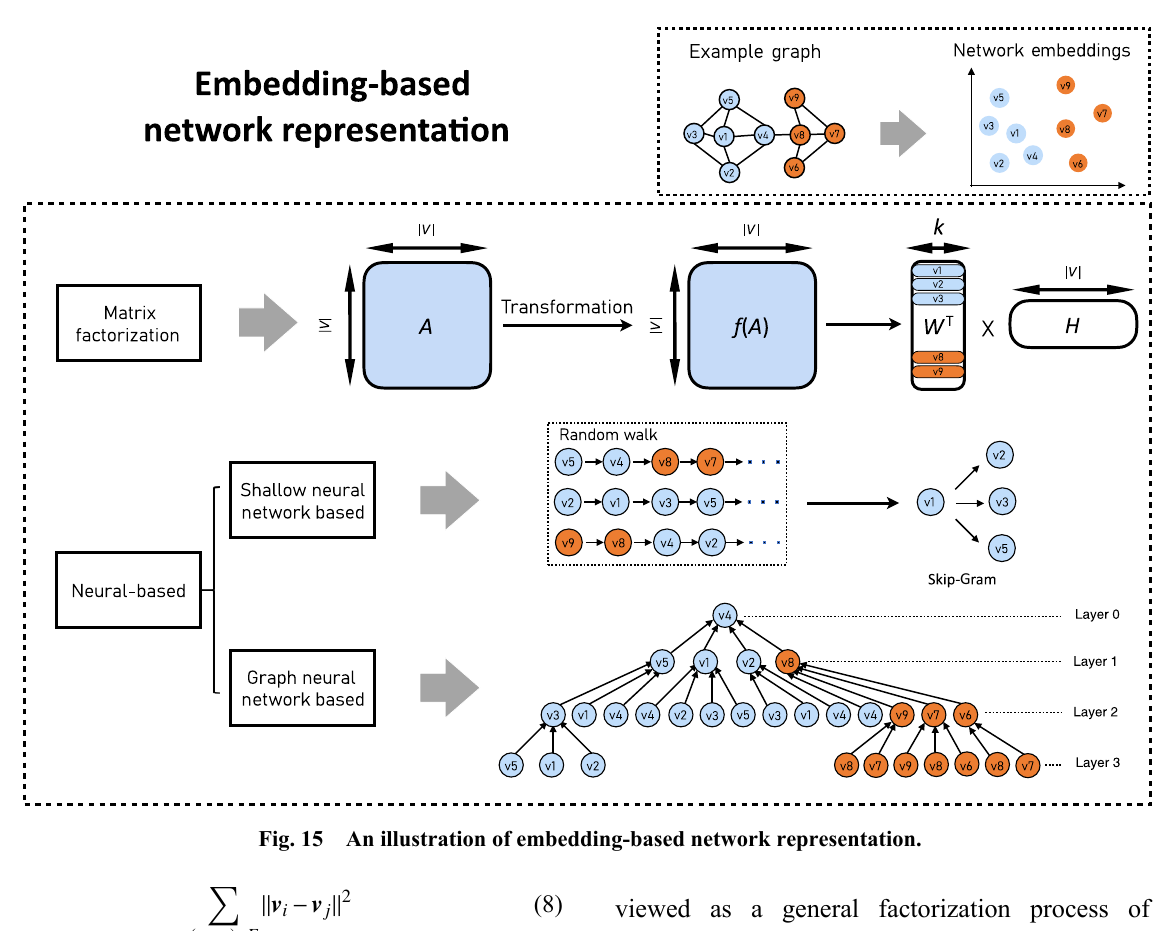
Fig. 15 An illustration of embedding-based network